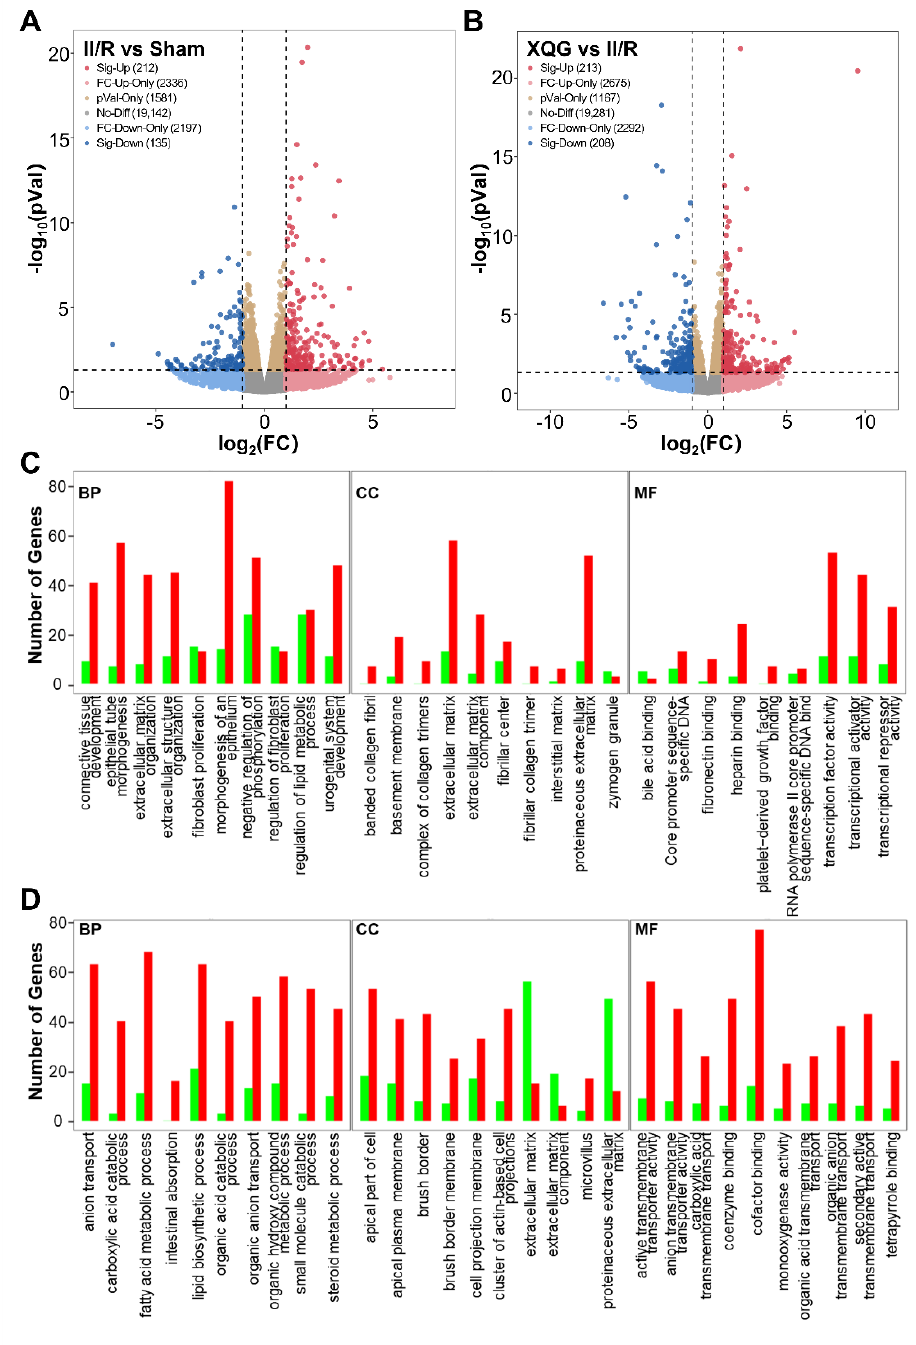
Figure 6. Differentially expressed genes and GO functional annotation. ( A , B ) Differentially e x- pressed genes after II/R injury ( A ) and XQG treatment ( B ); ( C , D ) GO functional annotation of the differentially expressed genes after II/R injury ( C ) and XQG treatment ( D ).